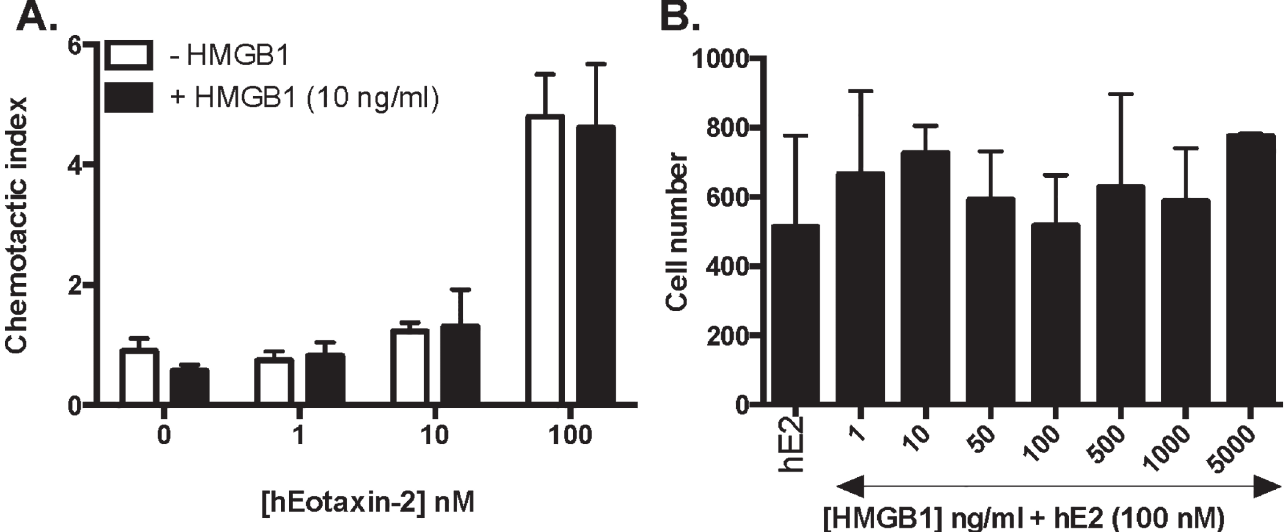
Fig 4. HMGB1 has no impact on eotaxin-2-mediated chemotaxis. Chemotaxis of peripheral blood eosinophils from normal donors evaluated in response to (A) increasing concentrations of human eotaxin-2 in the presence or absence of 10 ng/mL HMGB1 or (B) 100 nM human eotaxin-2 (hE2) in the presence of increasing concentrations of